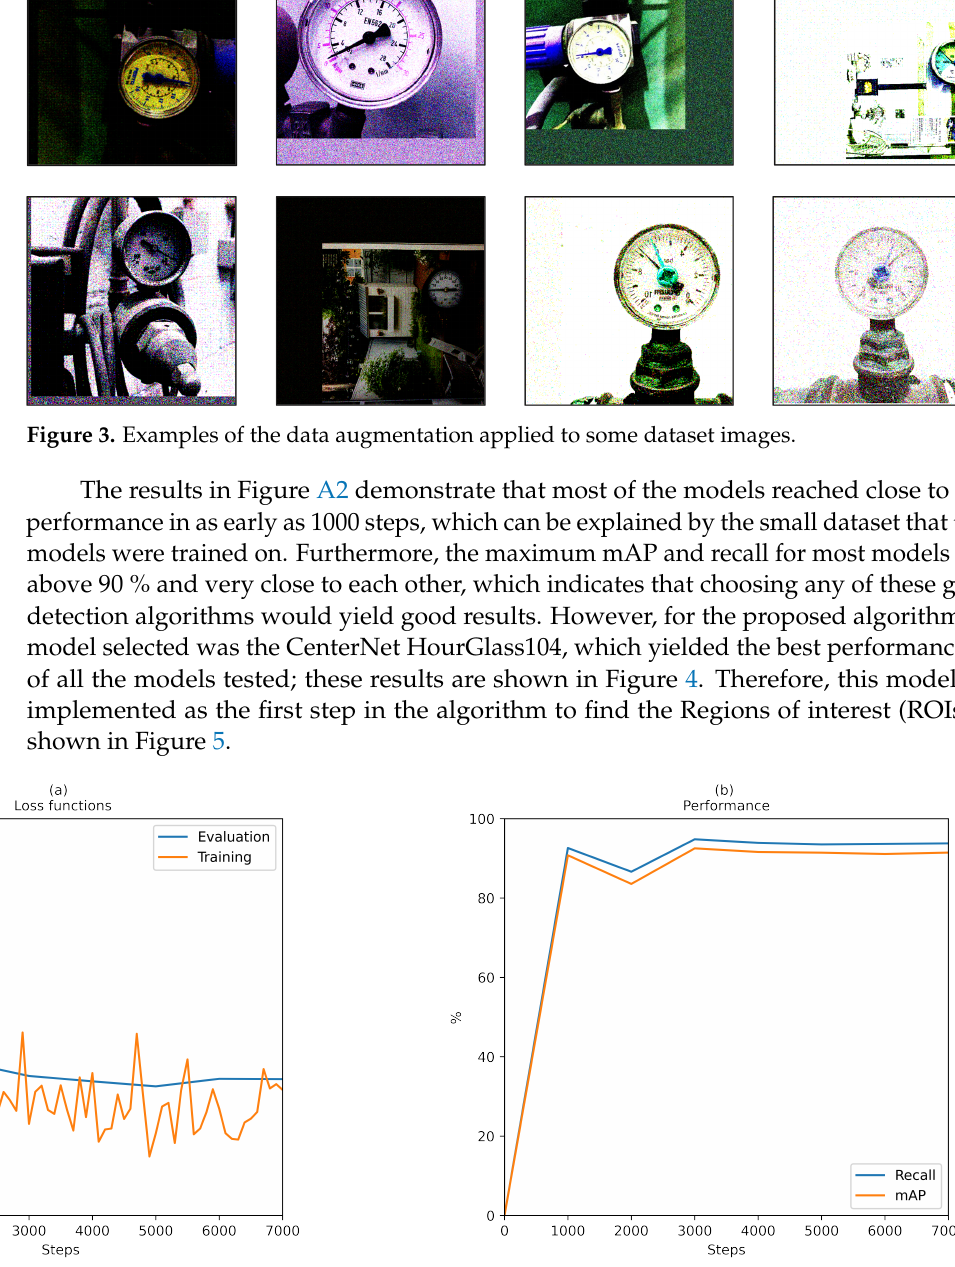
Figure 4. CenterNet HourGlass104 model Training. ( a ) Loss functions, ( b ) performance